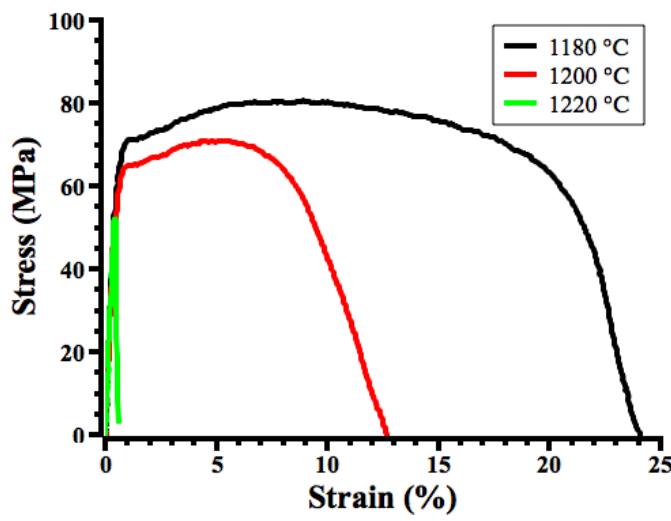
Figure 1. The stress-strain curve for A-286 specimens tested at different temperatures.